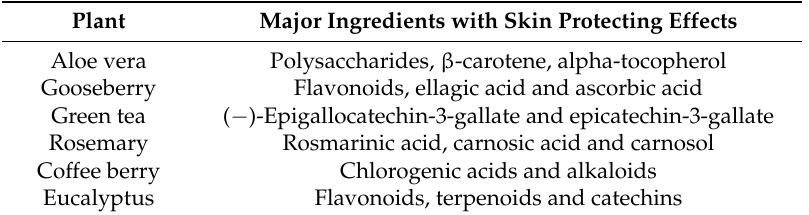
Table 1. Major plants and their active ingredients against skin photoaging